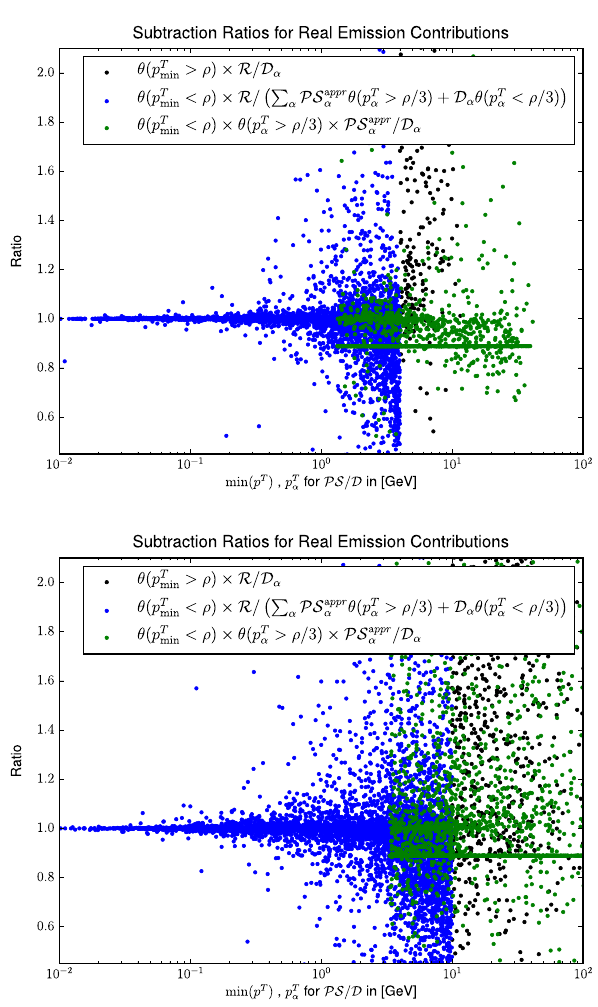
Fig. 5 Subtraction plot for the “1 ∗ ” real emission contribution in ee ( 0 ∗ , 1 ∗ , 2 ) and Z ( 0 ∗ , 1 ∗ , 2